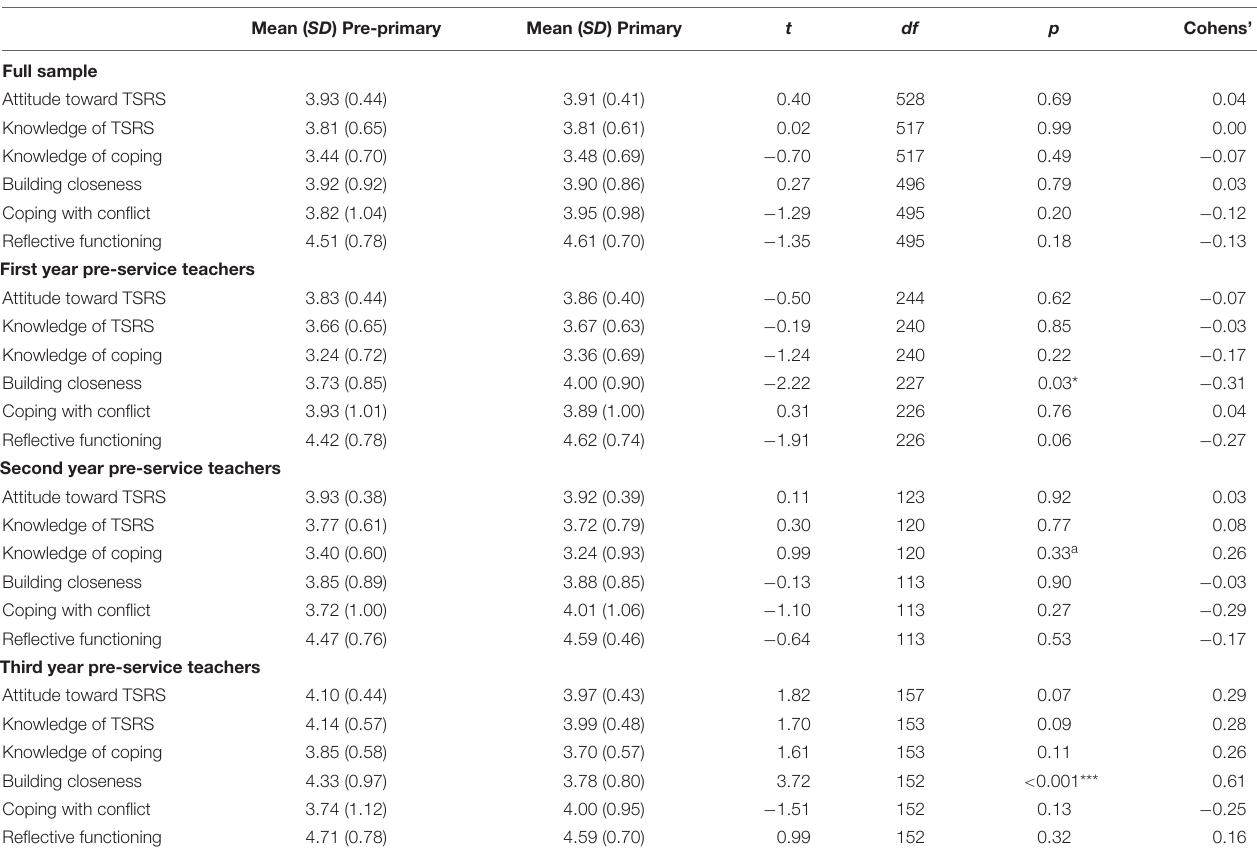
TABLE 11 | Comparison of pre-service teachers in the pre-primary or in the primary program: independent samples t -tests. Mean ( SD ) Pre-primary Mean ( SD ) Primary t df p Cohens’